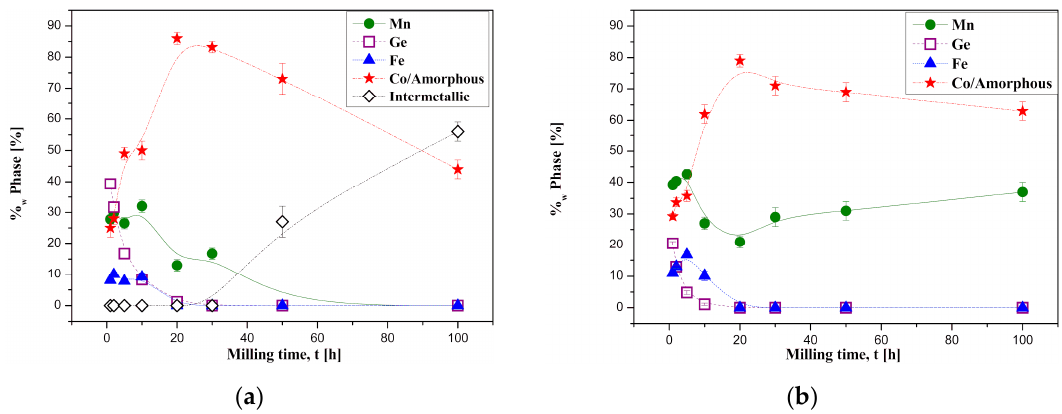
Figure 2. Phase fraction from XRD Rietveld analysis as a function of the milling time: ( a ) Si-free alloy ( b ) Si-containing alloy. Lines are a guide to the eye.